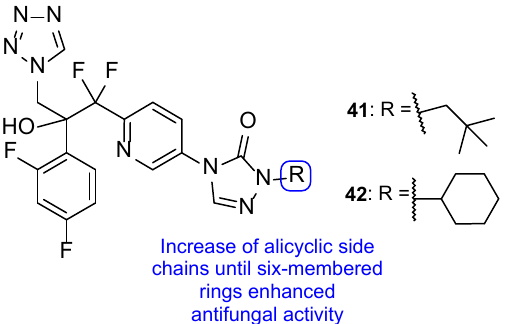
Figure 23. Chemical structures of compounds 41 and 42 , and SAR [103].